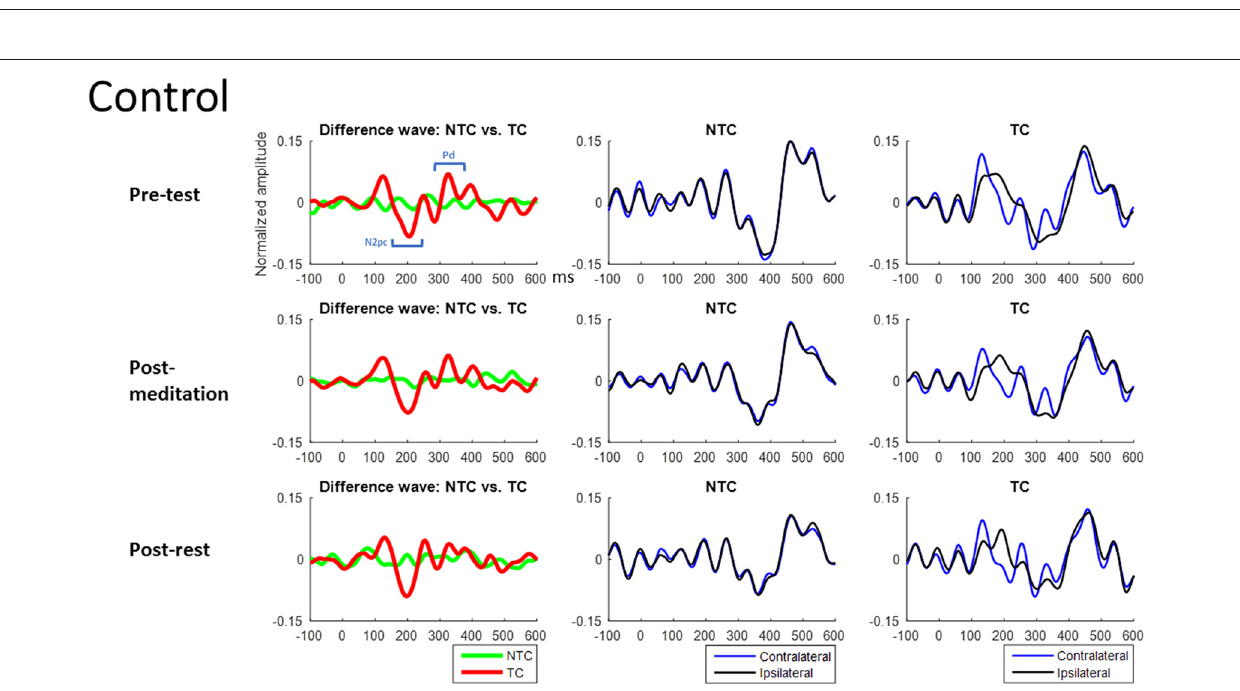
FIGURE 8 | Control group’s ERM waveforms from the RSVP task. The Waveforms of left Column were derived from the differences between contralateral and ipsilateral waveforms. The middle Column is the contralateral and ipsilateral waveforms of NTC condition. The right Column is the contralateral and ipsilateral waveforms of TC condition. The X -axis is time (ms), and 0 ms is distractor onset. The Y-axis is normalized amplitude. EEG data of all trials in each channel were normalized by dividing it into its standard deviation, therefore resulting in a unit-free measure of the amplitude.